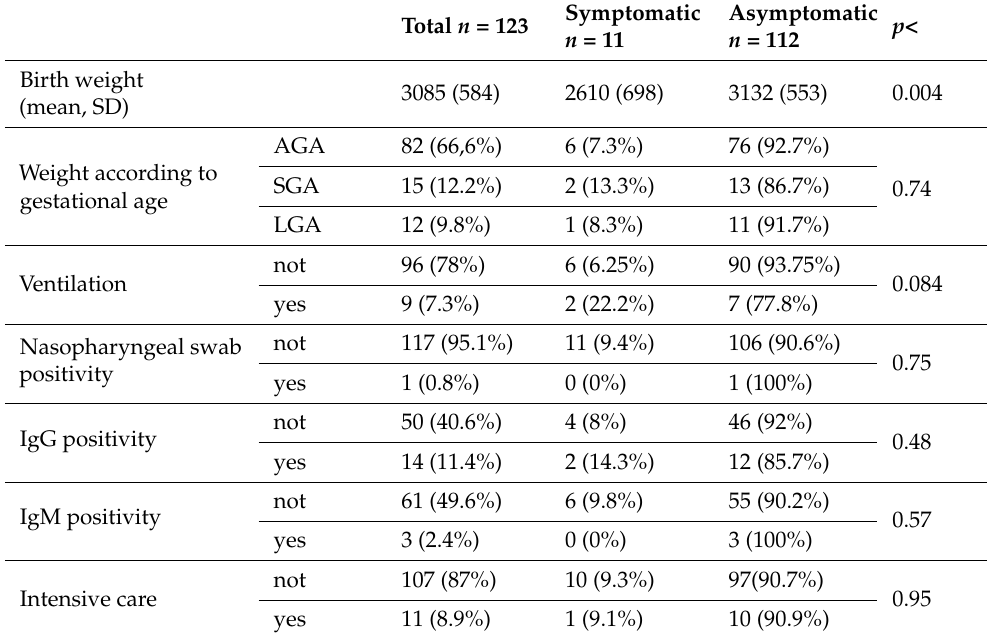
Table 3. Neonatal descriptive analysis.